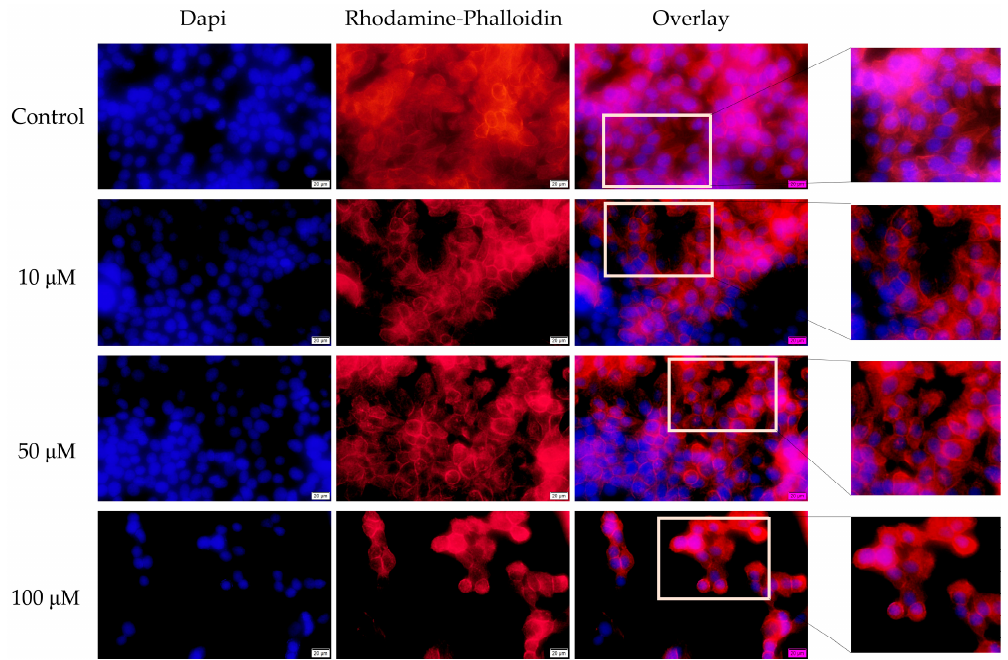
Figure 6. The impact of tetracycline (10, 50, and 100 µ M) after 72 h at the level of: nuclei—DAPI staining (blue) and F-actin fibers—Rhodamine Phalloidin (red). The pictures were taken using a 40 × objective at a scale bar of 10 µ